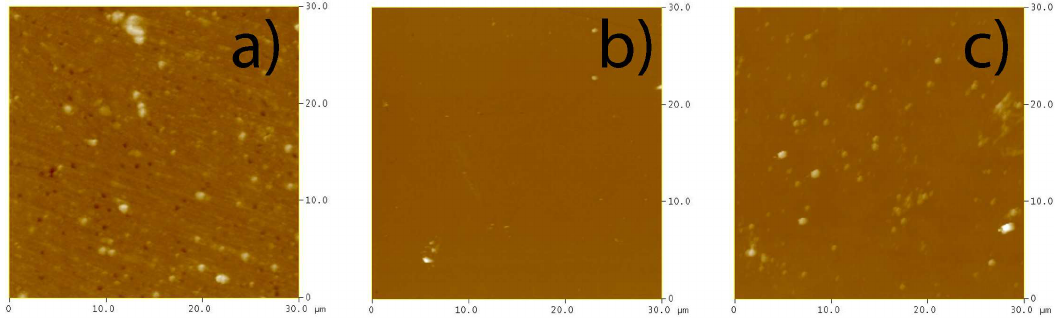
Figure 5. AFM images of selected coatings: ( a ) Bi0; ( b ) BiW1; and ( c ) TiO 2 . Table 2. Phase, surface, optical, and photocatalytic properties of coatings deposited onto 2 mm glass beads after annealing at 673 K.